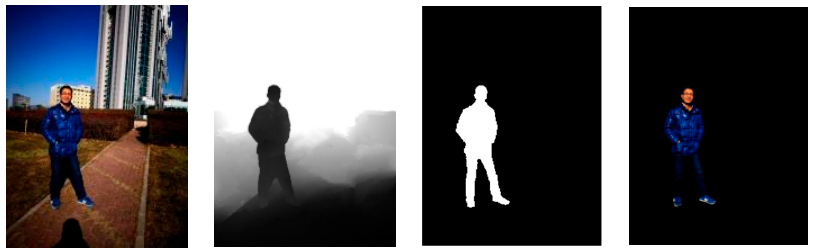
Figure 1. From left to right, RGB images, depth images, the ground truth of the SOD method, and the ground truth of our method.